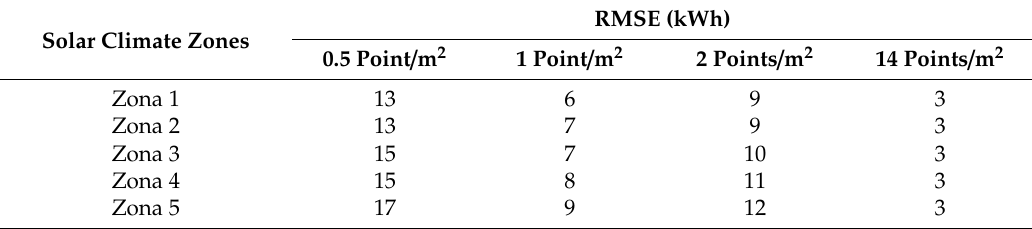
Table 19. Average daily PV energy production loss (kWh) due to the error in the estimation of the rooftop area for di ff erent point cloud densities: residential building with a hipped roof of 400 m 2